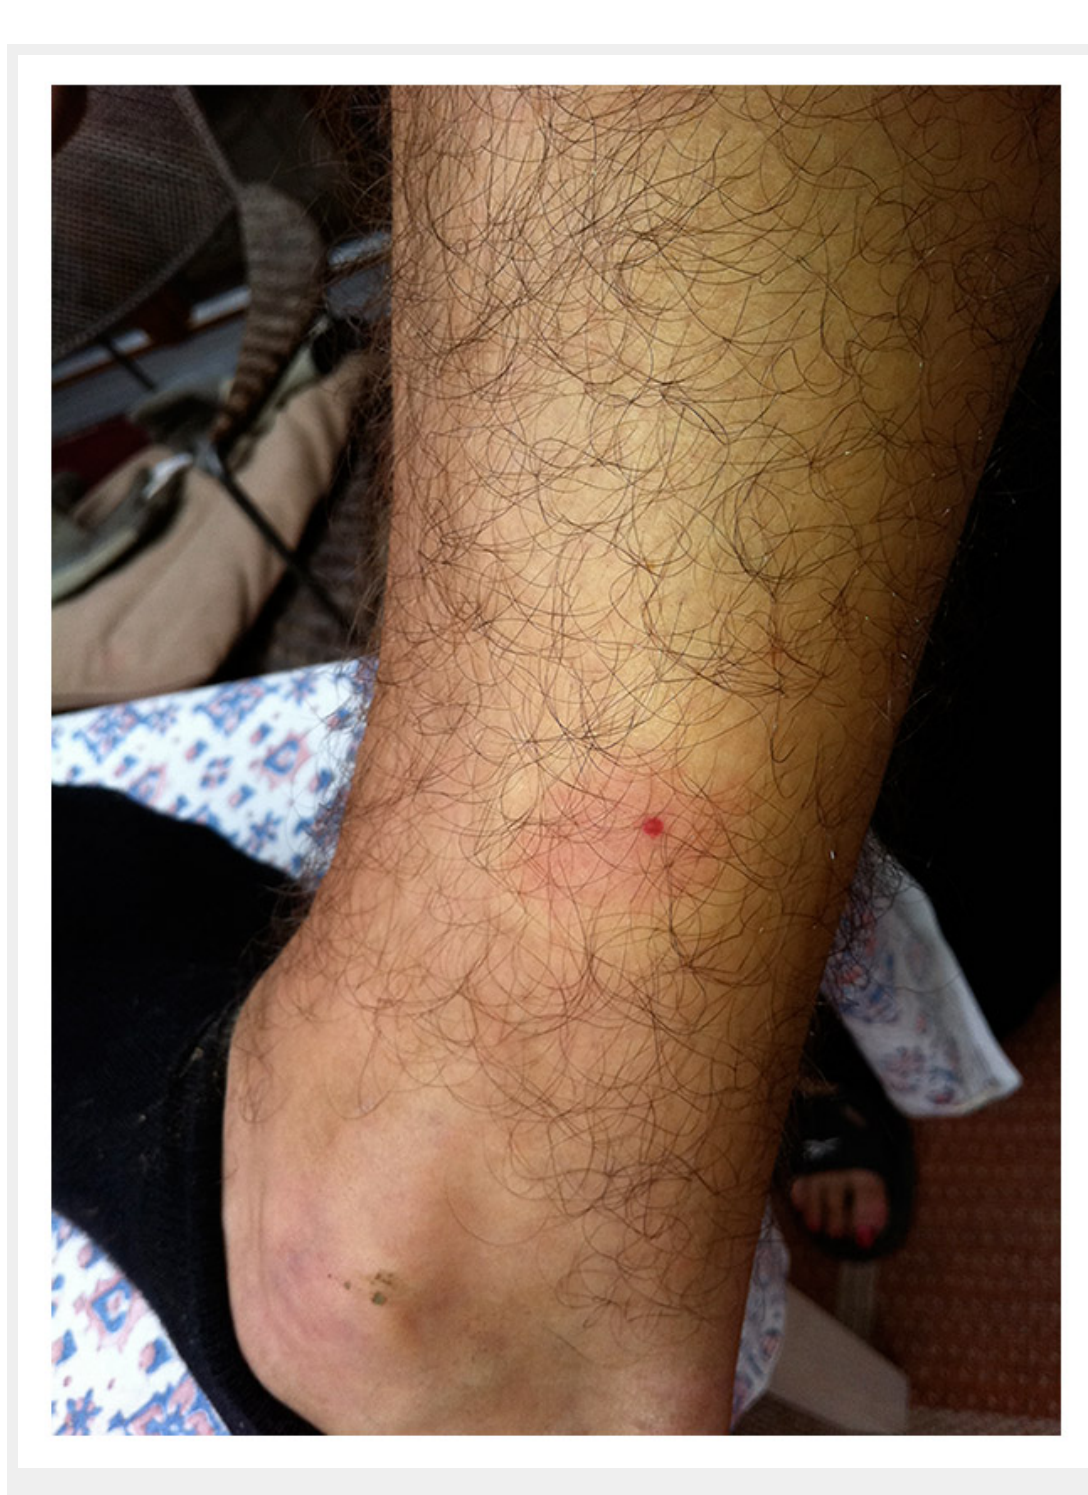
Figure 1 Leg of patient 1, two hours after bite by Amaurobius ferox